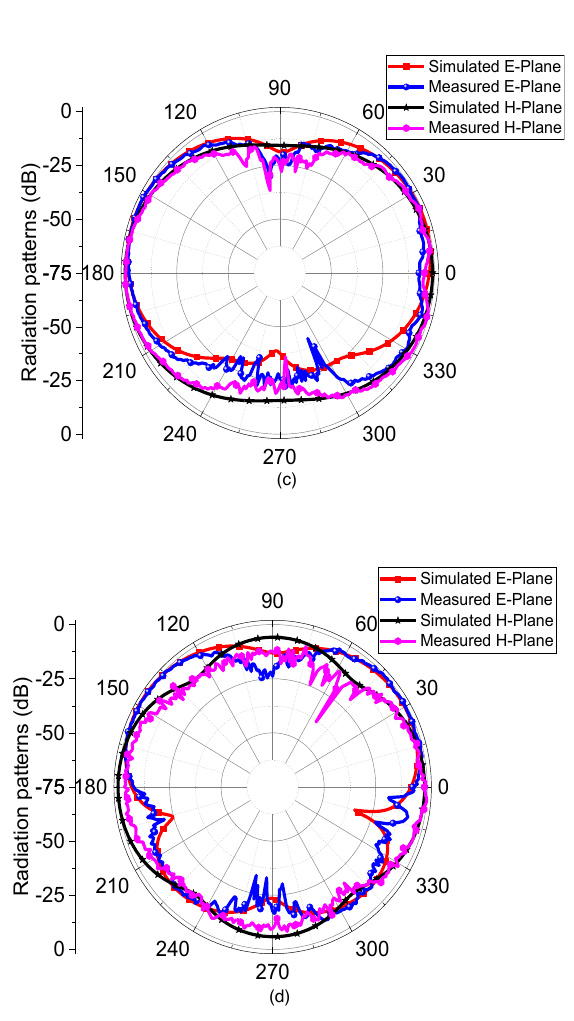
FIGURE 10. Simulated and Measured radiation patterns at four frequencies: (a) 3.6 GHz, (b) 5.77 GHz, (c) 8.33 GHz, (d) 10.43 GHz. Simulated E-Plane The antenna radiation patterns measurements of the Measured E-Plane fabricated prototype were measured in an isolated anechoic Simulated H-Plane Measured H-Plane chamber. The experimental setup exploits two antennas which are the transmitting antenna (double ridged horn antenna-model AH-118 (1-18) GHz) and the antenna under test (the fabricated prototype) which is used as a receiving antenna. The simulated and measured values of radiation patterns in the xz -plane ( H -plane) and the yz -plane ( E -plane), at four frequencies (3.6 GHz, 5.77 GHz, 8.33 GHz, and 10.43 GHz), are reported in fig. 10. Similar to the results reported in [25,26], it is remarkable that the fabricated prototype has almost omnidirectional patterns in the H -plane and nearly bidirectional patterns in the E -plane. However, at higher frequencies, the far-field radiation patterns undergo inconsistency that is due to the excitation of higher order modes.